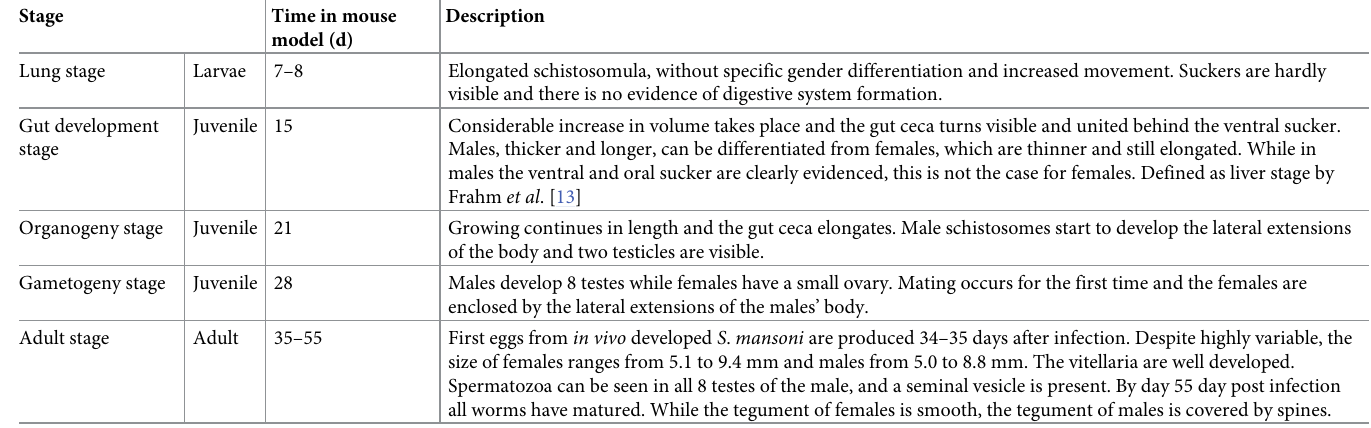
Table 1. Assignment of developmental stage according to morphology and organ